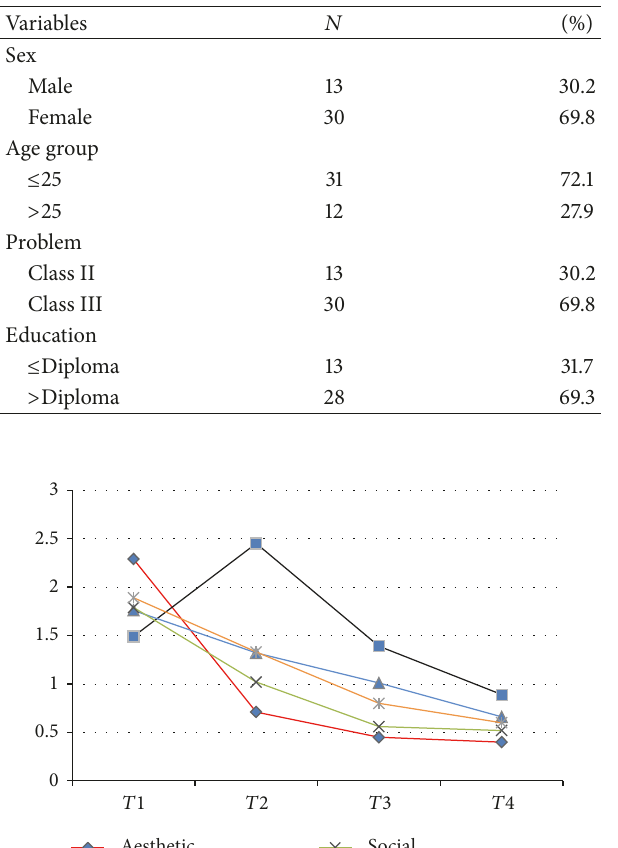
Table 1: Demographic characteristics of patients.